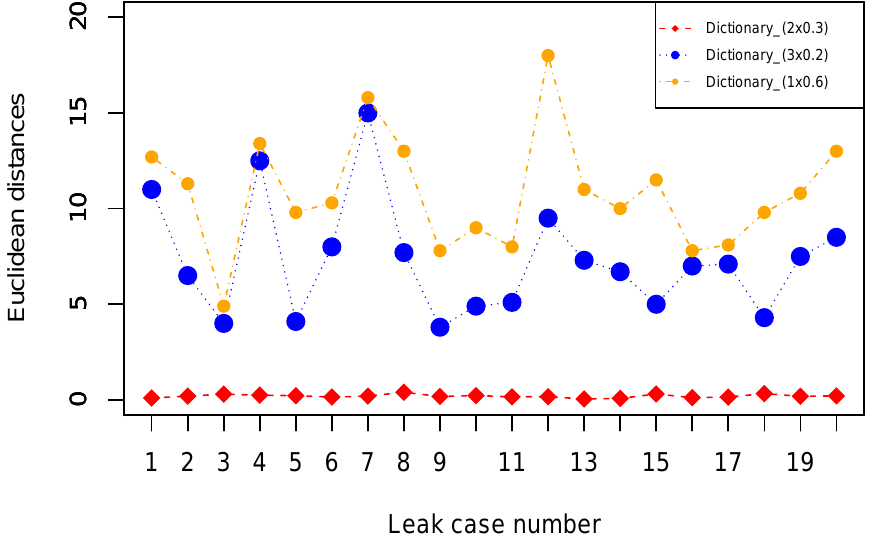
Figure 4. Euclidean Distances of double leak vectors at 0.3 lps against D 0.6 , D 2 × 0.3 and D 3 × 0.2